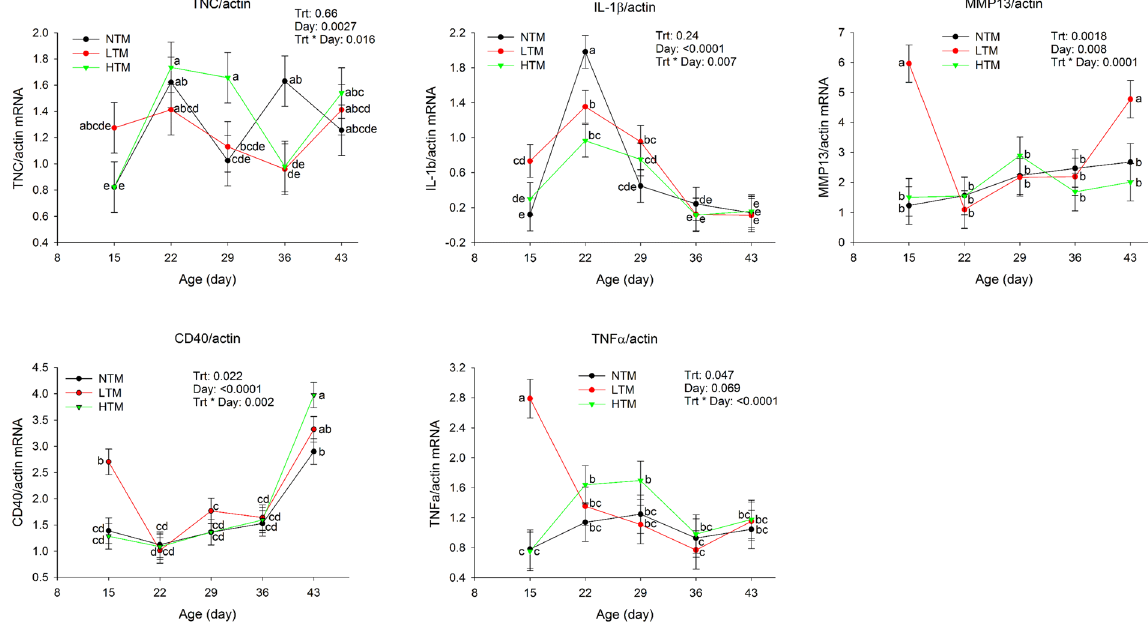
Figure 2. Gene expression of TNC, IL-1 β , MMP13, CD40 and TNF α in footpad of broilers fed three levels of TM at different ages. There was interaction between treatments and age. Means with different letters differ at P < 0.05.